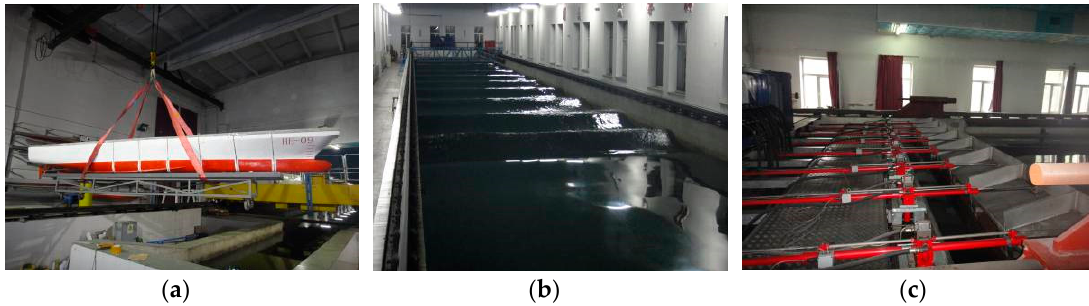
Figure 3. Model and tank facilities. ( a ) Model overview; ( b ) wave tank; ( c ) wave-maker.